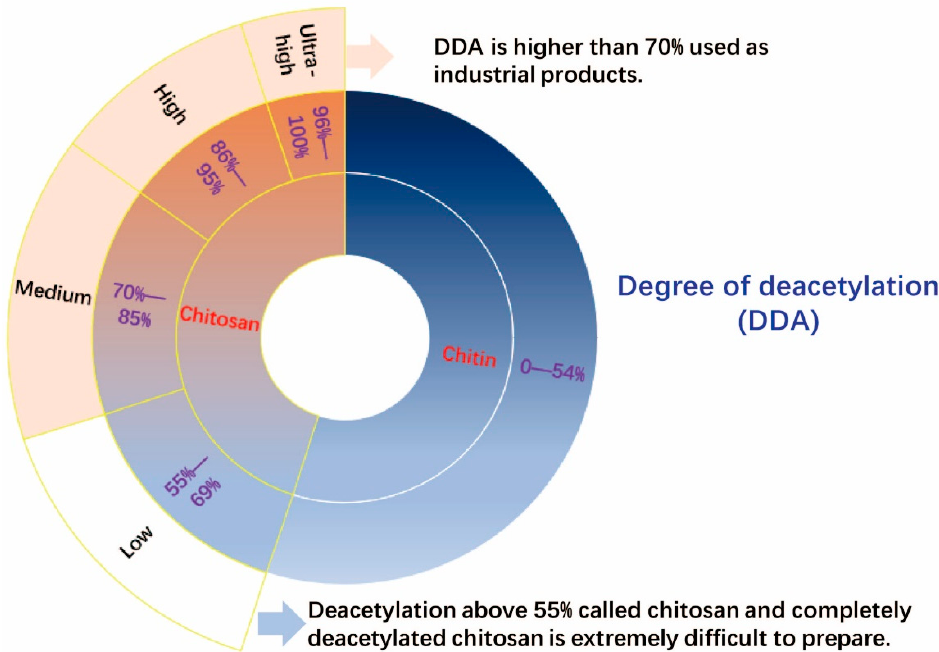
Figure 3. The deacetylation degree classification standard of chitosan.